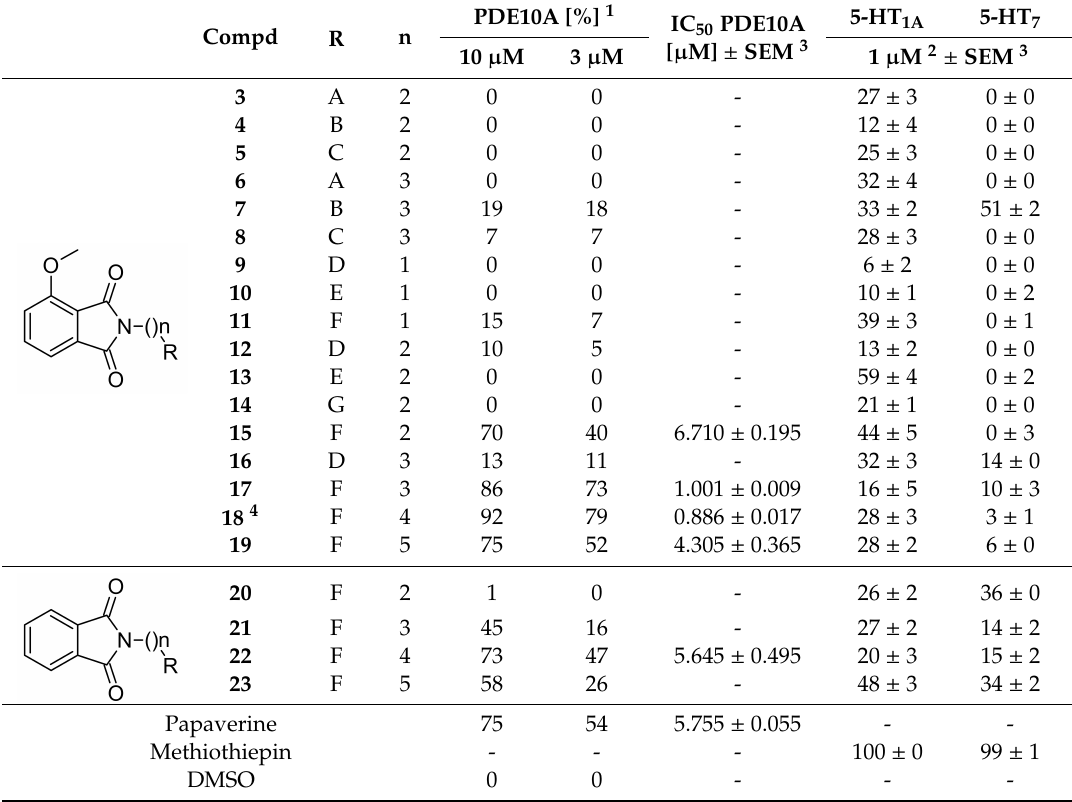
Table 1. Screening data from a luminescence PDE inhibition assay and a radioligand binding assay for 5-HT 1A and 5-HT 7 (%) of 4-methoxy-1 H -isoindole-1,3(2 H )-dione and 1 H -isoindole-1,3(2 H )-dione derivatives displaying phosphodiesterase 10A inhibitory activity and binding a ffi nity for serotonin 5-HT 1A and 5-HT 7 receptors as well as selected IC 50 values of the most active compounds for